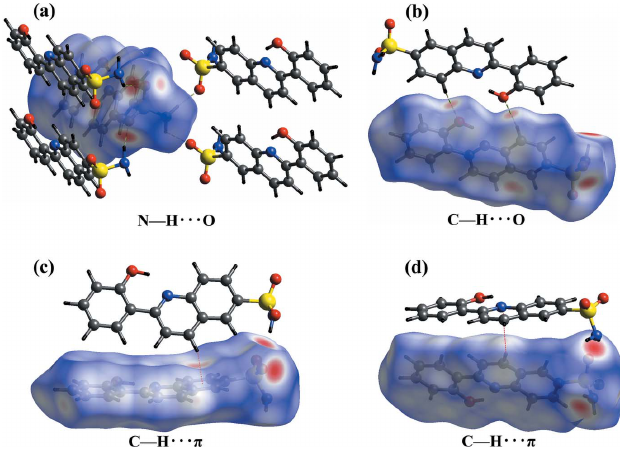
Figure 8 Views of the Hirshfeld surface mapped over d norm showing ( a ) and ( b